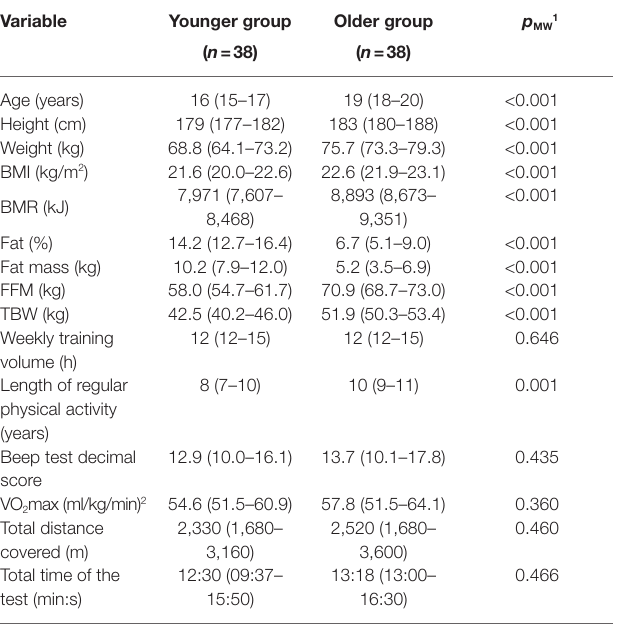
TABLE 1 | Body composition of the